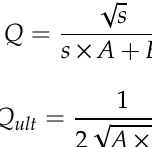
Figure 9. Example of pile head load and displacement vs. time plot for the traditional static load test.